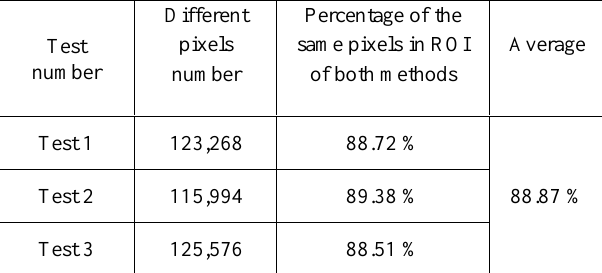
Table 6. The comparison of result between ROI automatic detection and ROI manual